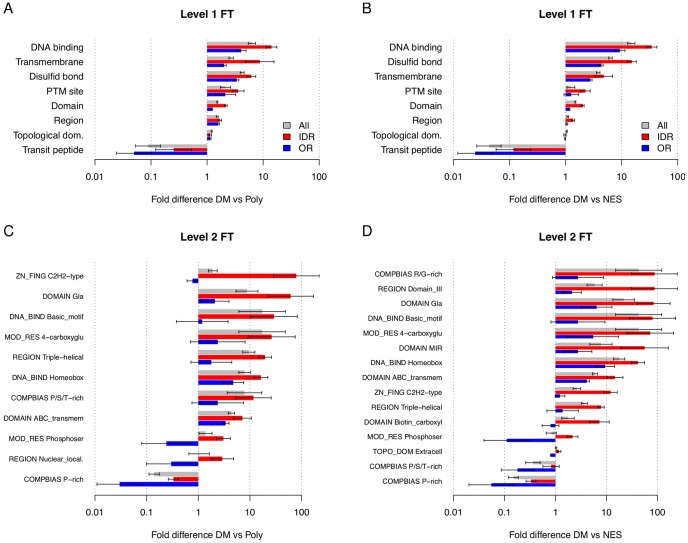
Fold differences of UniProt FT annotations in DM compared to Poly (panels A,C) and NES (panels B,D) that show statistically significant frequency difference between mutations in IDR and OR.Top row (A, B) contains level 1 and the bottom row (C, D) level 2 features. Error bars are one standard error of fold difference. Categories are sorted by decreasing fold difference in DM compared to controls.